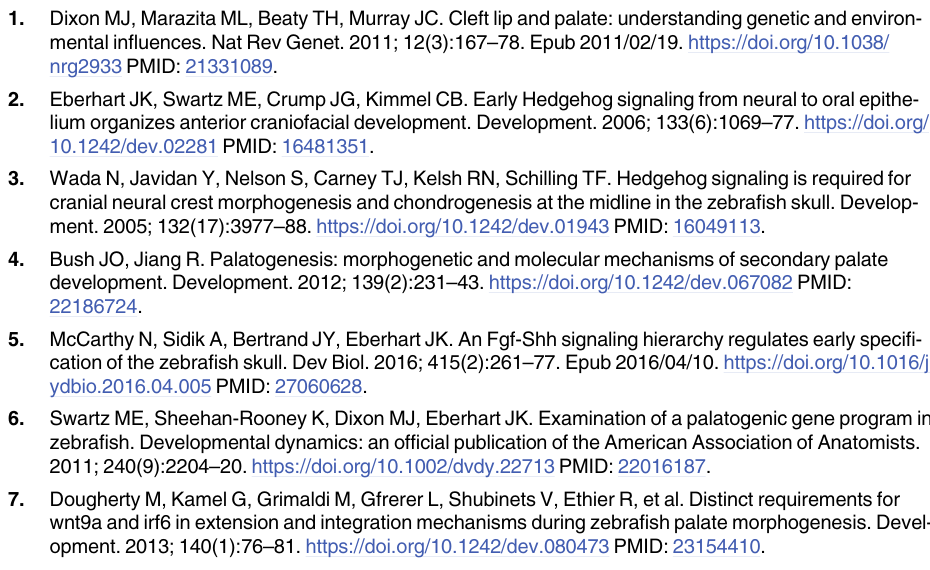
S6 Fig. Whole mount RNA Scope version 2 fluorescent in situ